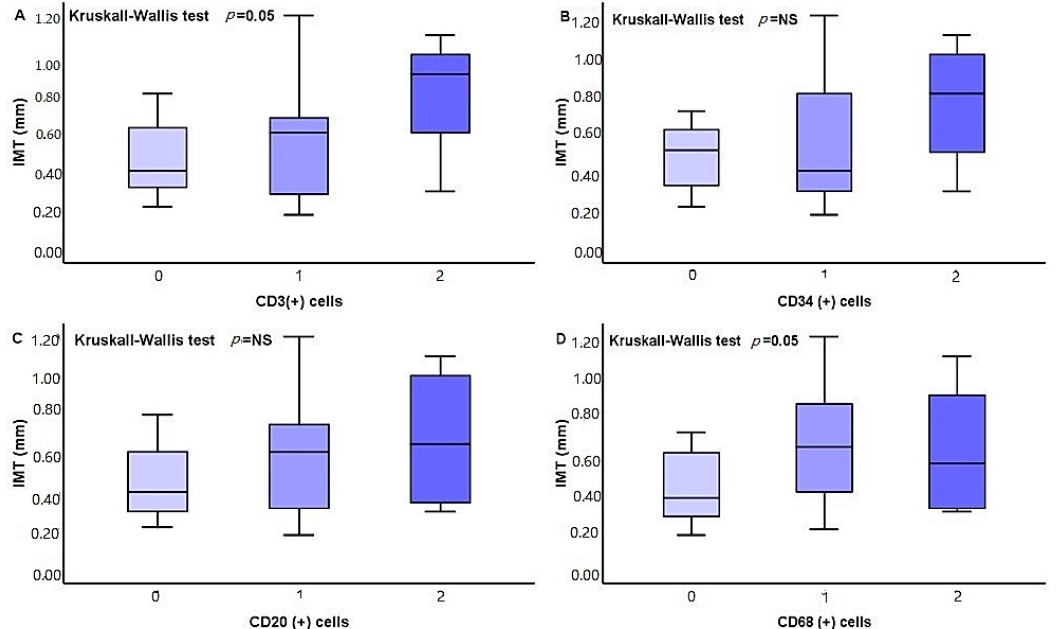
Figure 3. Differences in IMT cells according to the severity of radial artery infiltration by CD3(+) ( A ), CD34(+) ( B ), CD20(+) ( C ), and CD68(+) ( D ) cells.